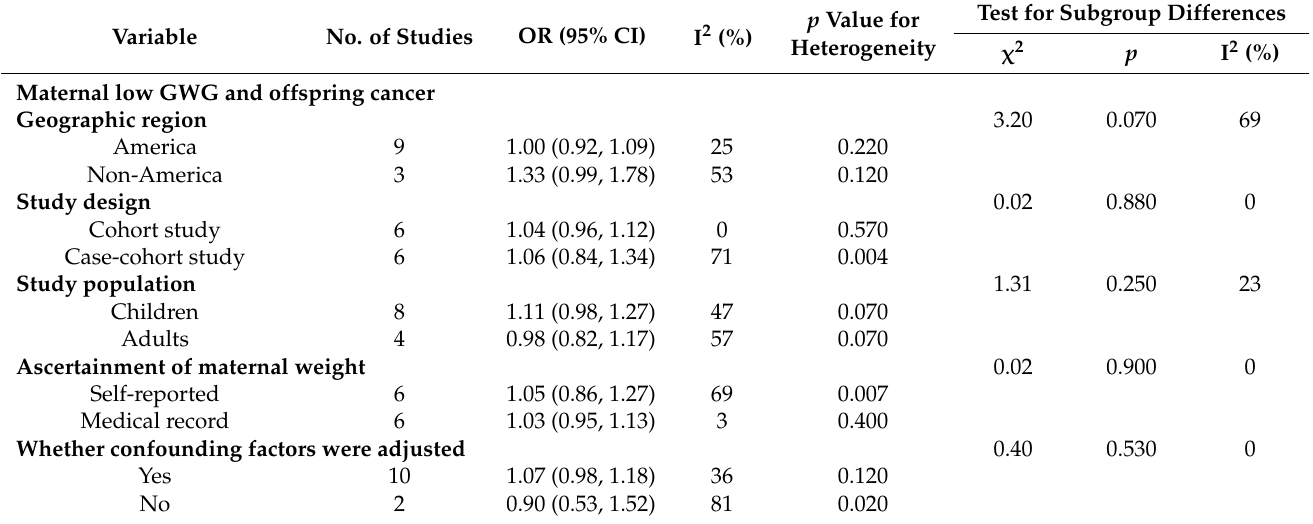
Table 3. Subgroup analyses for the association between GWG and risk of cancer in